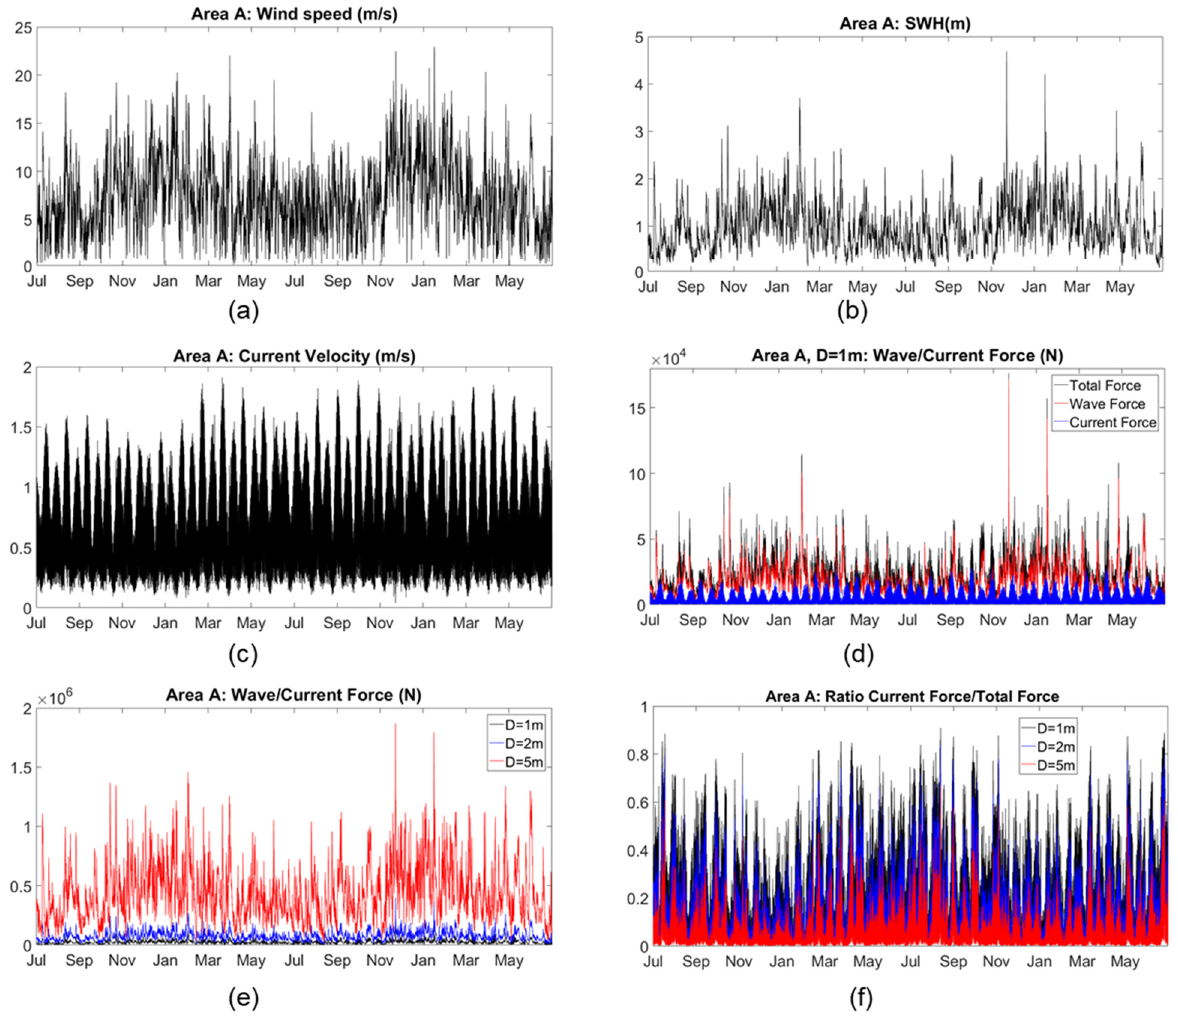
Figure 8. Area A hourly time series (7/2014–6/2016) of area-averaged wind speed (m/s) ( a ) Significant Wave Height (m) ( b ), Current velocity (m/s) ( c ), total wave/current force (N) (black), wave force (N) (red) and current force (N) (blue) ( d ) on a pile of diameter 𝐷 = 1 m. Timeseries of total force ( e ) and ratio of current to total Force ( f ) for 𝐷 =1 m, 𝐷 =2 m, and 𝐷 =5 m.